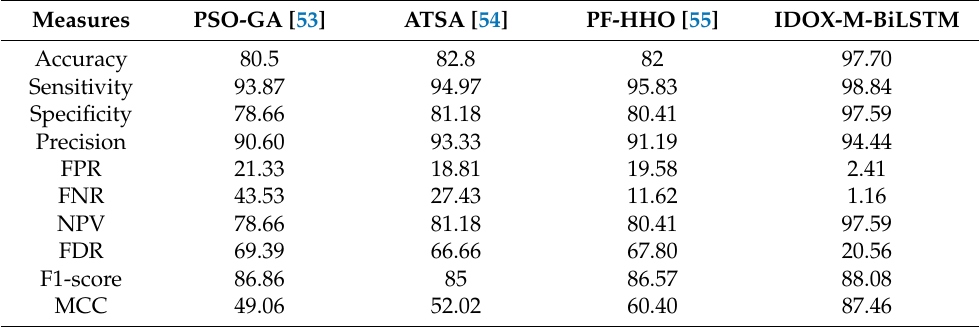
Table 5. Validation of the developed heart disease prediction model in WBAN with several recent prediction